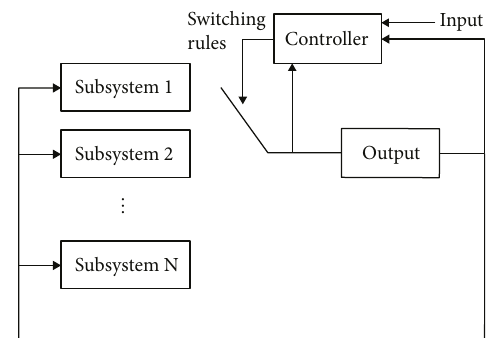
Figure 1: A simple schematic diagram of the switching system.